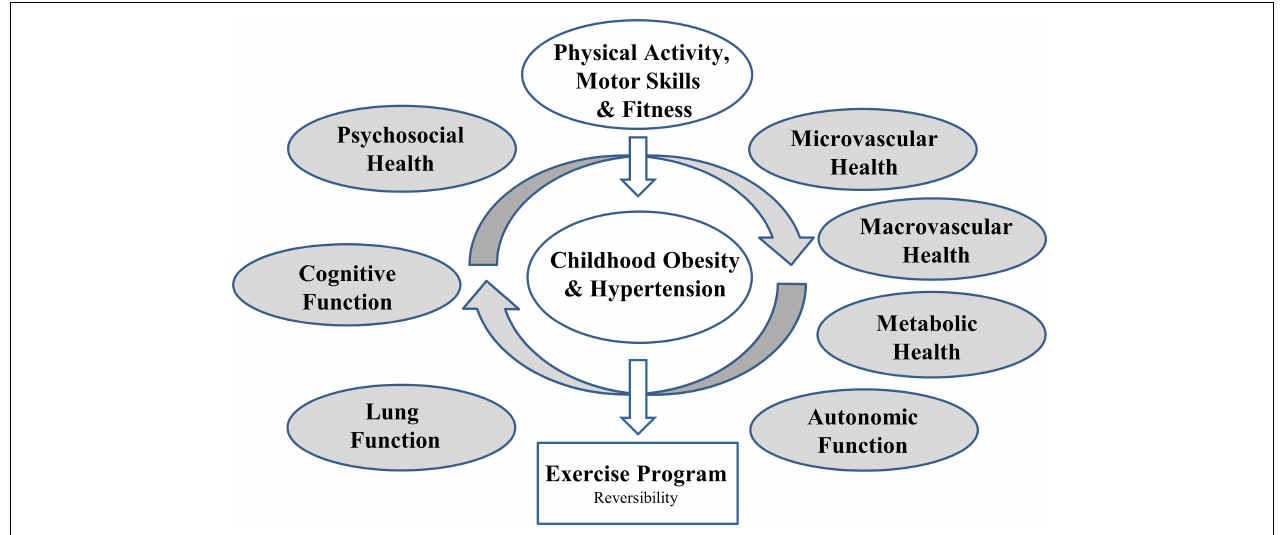
FIGURE 1 | EXAMIN YOUTH study